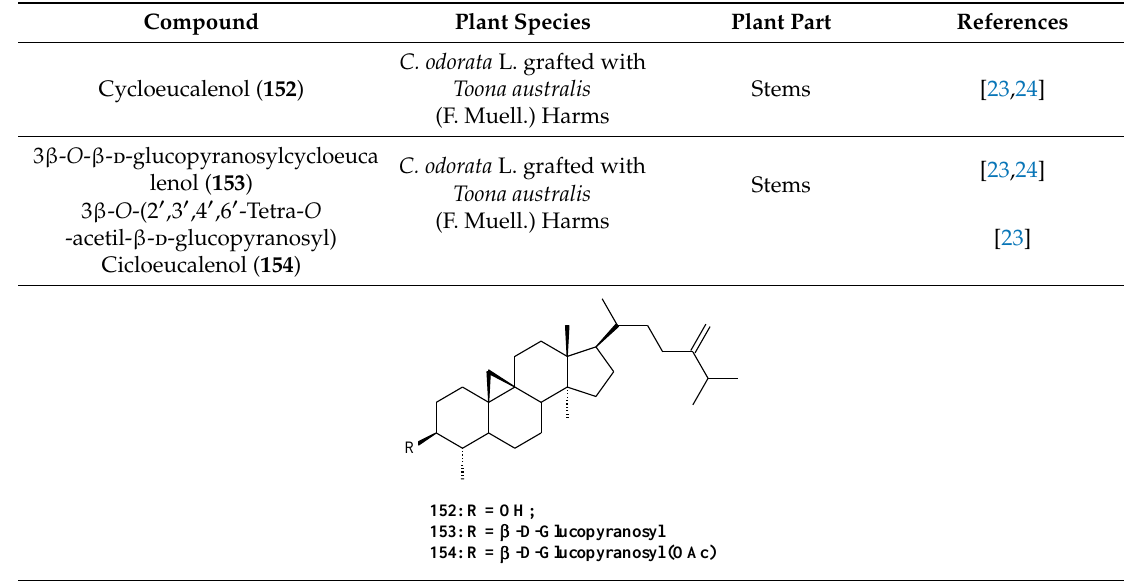
Table 7. Cycloartanes isolated from the genus Cedrela (1960–2020).